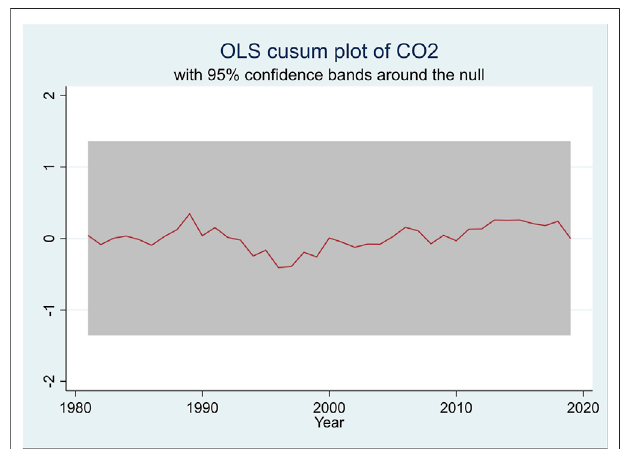
FIGURE 4 | Cumulative sum test using OLS CUSUM plot for parameter stability.